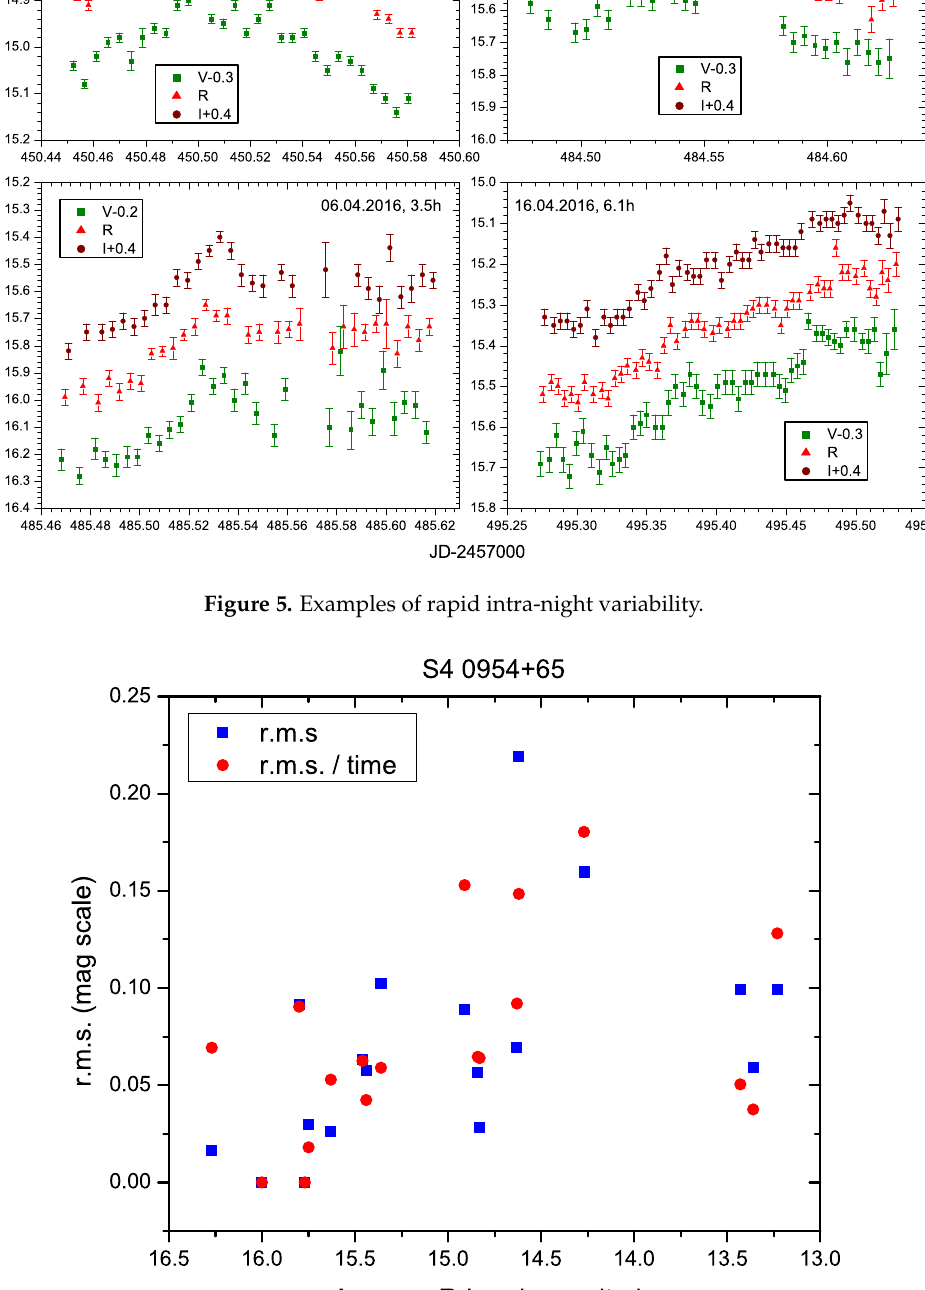
Figure 6. “rms-flux” relation for all intra-night observing sets. A clear tendency of higher rms in brighter states can be seen (correlation coefficient of about 0.5). Blue squares show rms, calculated for each observing set, and the red circles are the time normalized rms, to account for the possible influence of the duration of the set. Both show similar